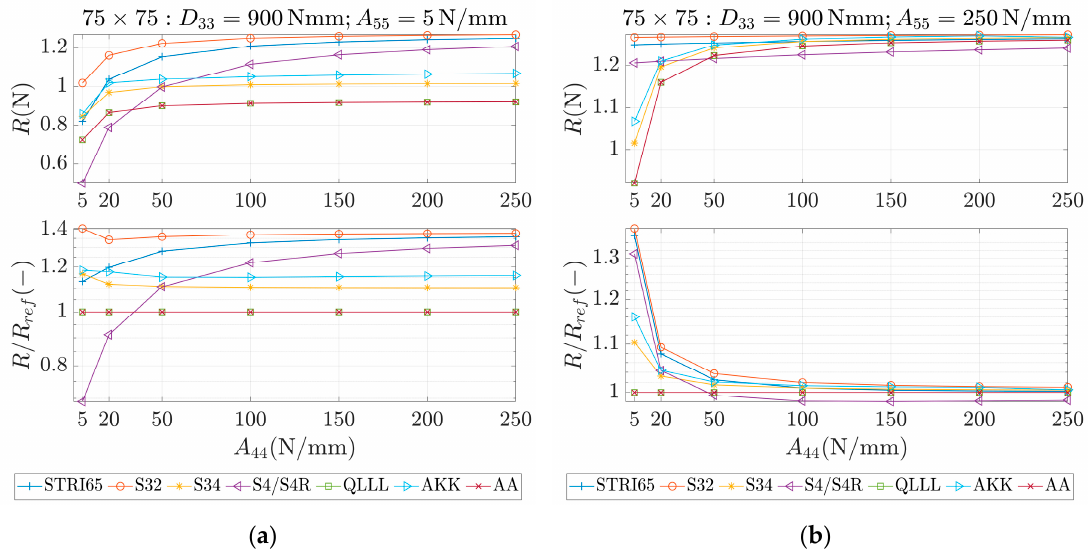
Figure 7. Reactions (first row) and reactions to the reference (analytical) solution (second row) for 75 × 75 sample, 𝐷 (cid:2871)(cid:2871) = 450 Nmm and different values of 𝐴 (cid:2872)(cid:2872) . ( a ) 𝐴 (cid:2873)(cid:2873) = 5 N/mm and ( b ) 𝐴 (cid:2873)(cid:2873) = 250 N/mm.